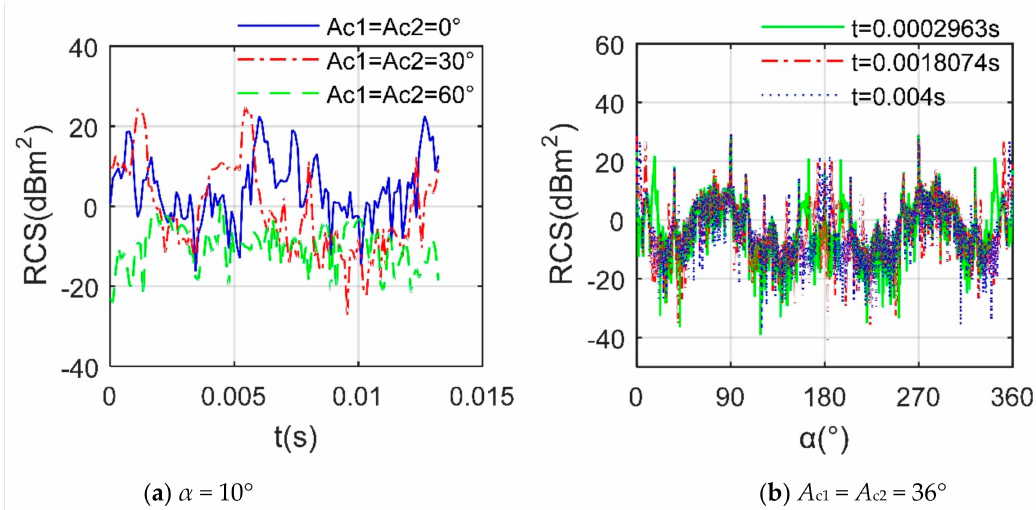
Figure 12. RCS curves of the tilt rotor aircraft, f rh = 10 GHz, β = 0 ◦ , n r1 = n r2 = 1500 r/min. ( a ) RCS curve at α = 10 ◦ . ( b ) RCS curve at A c1 = A c2 = 36 ◦ .